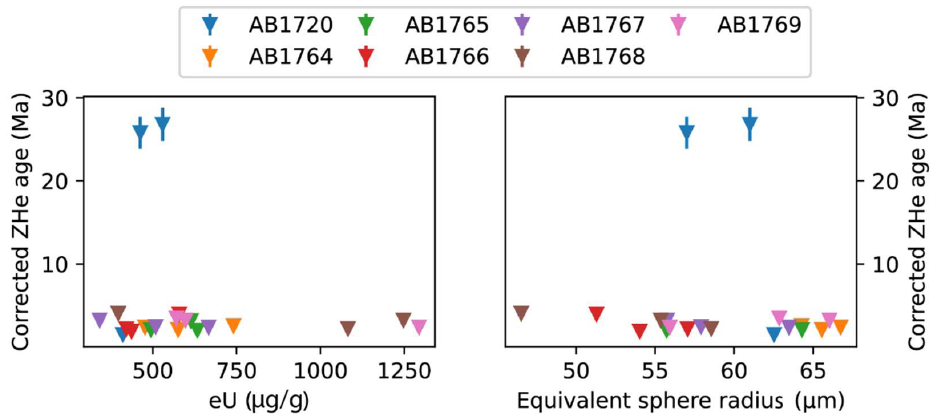
Figure 3. ZHe grain age of all the samples from the Machu Picchu vertical profile as a function of the equivalent uranium concentration (eU; left panel) and the equivalent sphere radius (ESR, right panel). Error bars are mostly smaller than the size of the points. There are no clear trends.